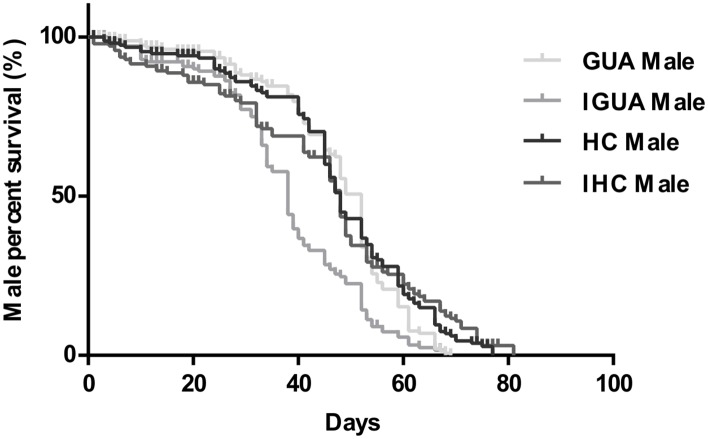
Adult survival curves for the Aedes albopictus HC/IHC, and GUA/IGUA males.Day number indicates time post-emergence. Kaplan-Meier curves were used to estimate male adult survival.